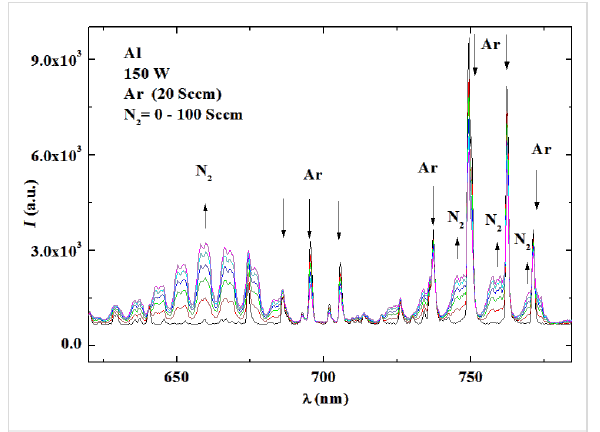
Figure 5: Spectrum of the emission lines. Details of AlN for different values of N 2 flux (starting from 0 and going up to 100 sccm in steps of 20 sccm, the colors are as follows: black, red, green, dark blue, cyan, and magenta) at fixed power (150 W) and an Ar flux of 20 sccm.